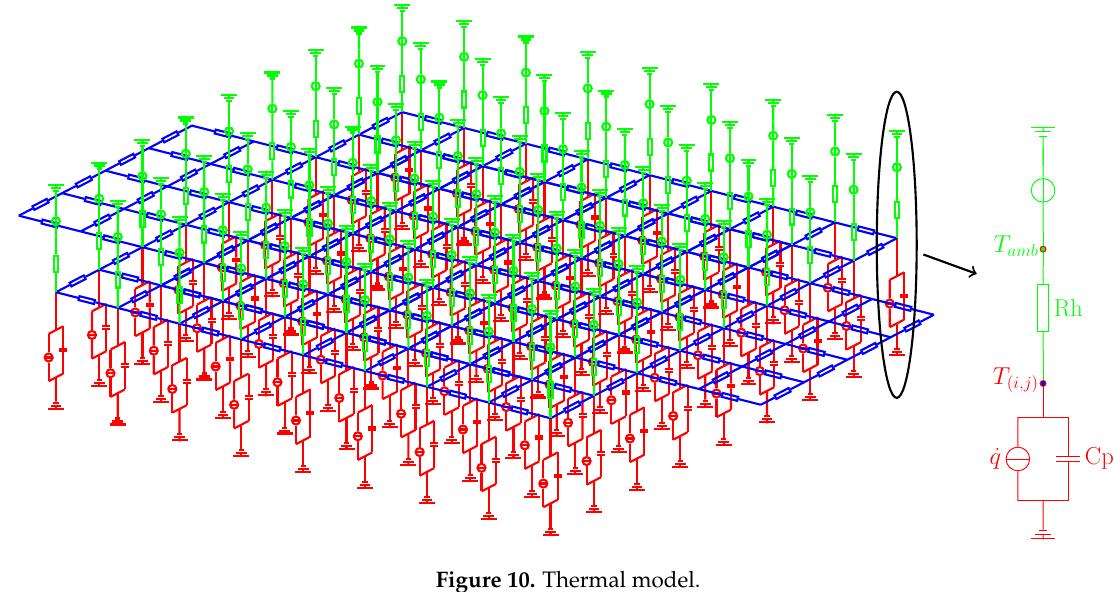
Figure 10. Thermal